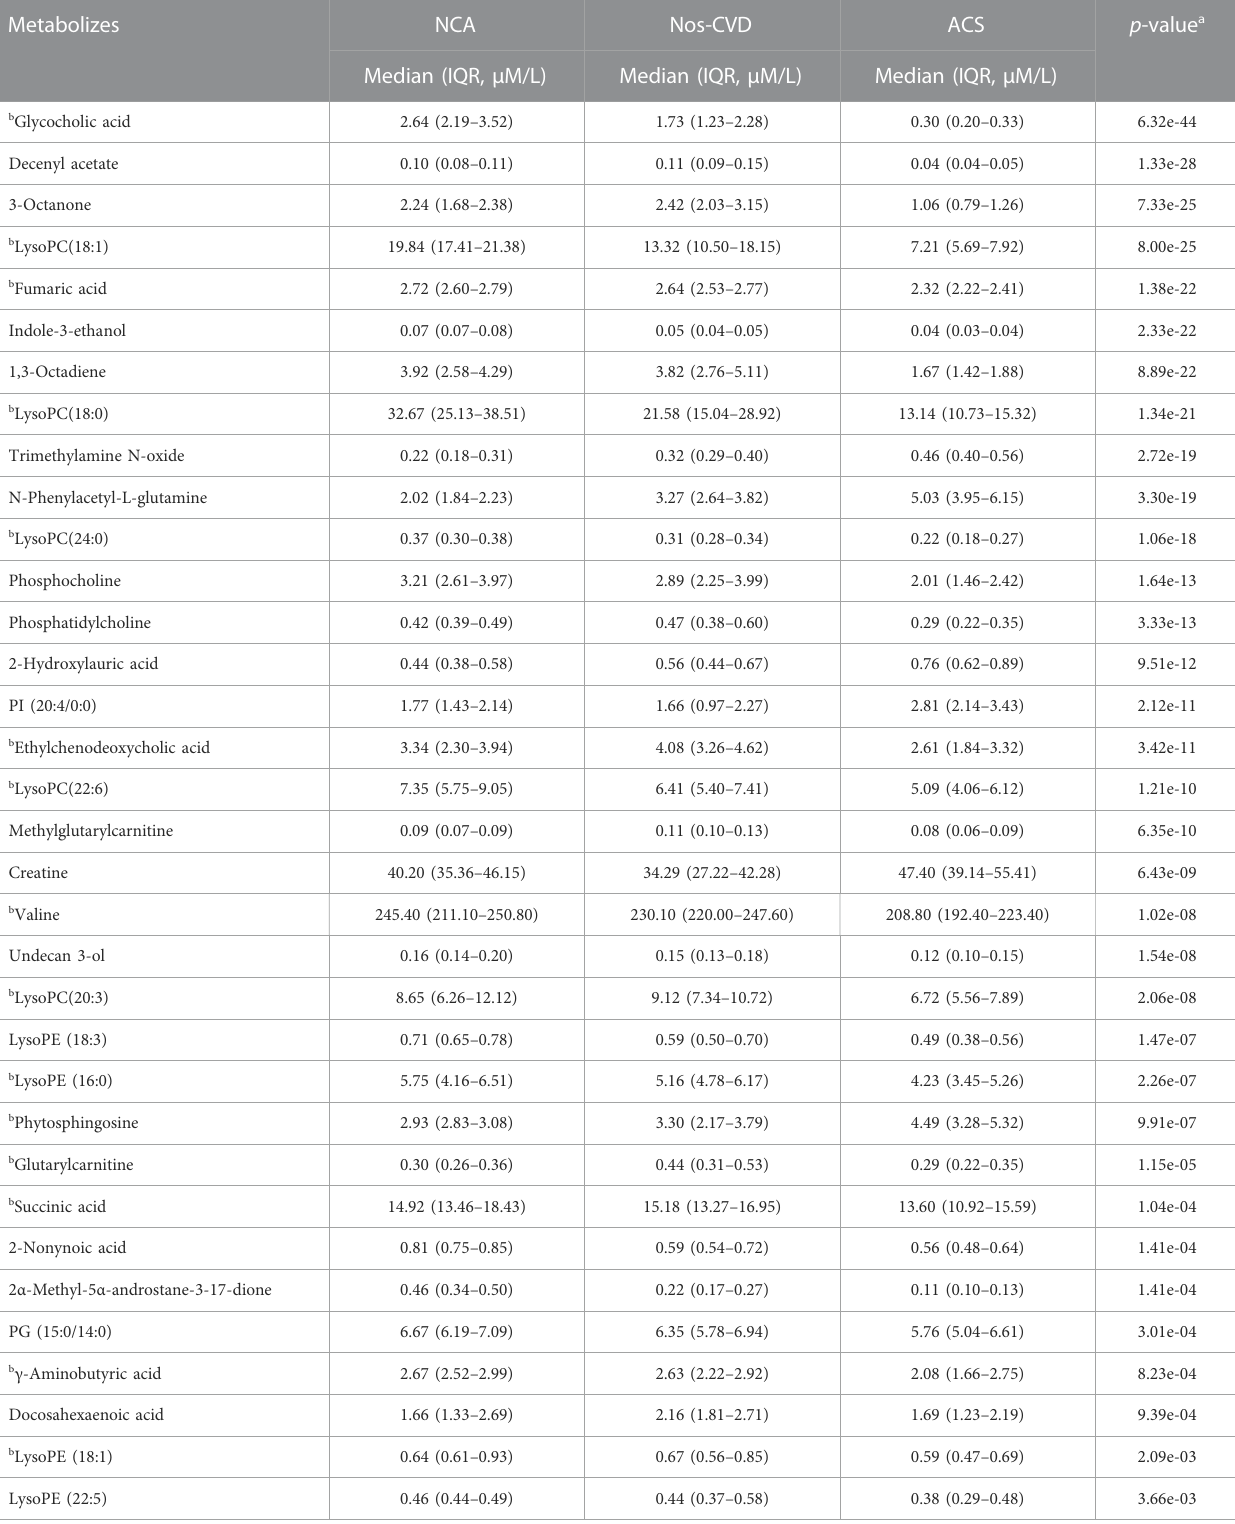
TABLE 2 The metabolites identi fi ed by both in the training and test